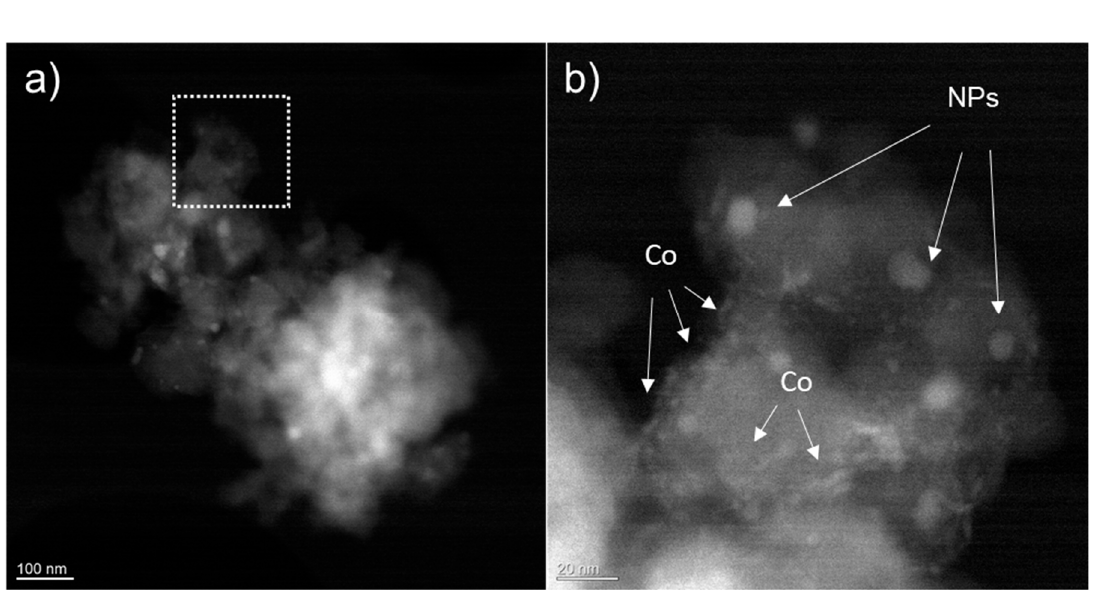
Figure 6. ( a ) HAADF STEM overview image showing a grain of material after stability measurements. ( b ) A higher magnification image corresponding to the dotted box areas in ( a ). Nanoparticles are visible as well as the remnant of the Co electrodeposited network.